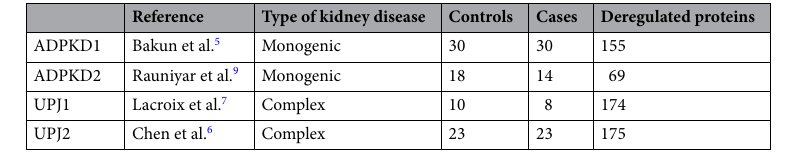
Table 1. Dataset